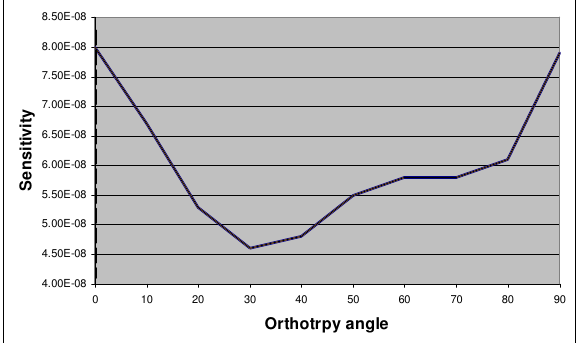
Fig 4. Approximated values of sensitivity of in-plane Poisson’s ratio to the orthotropy angle